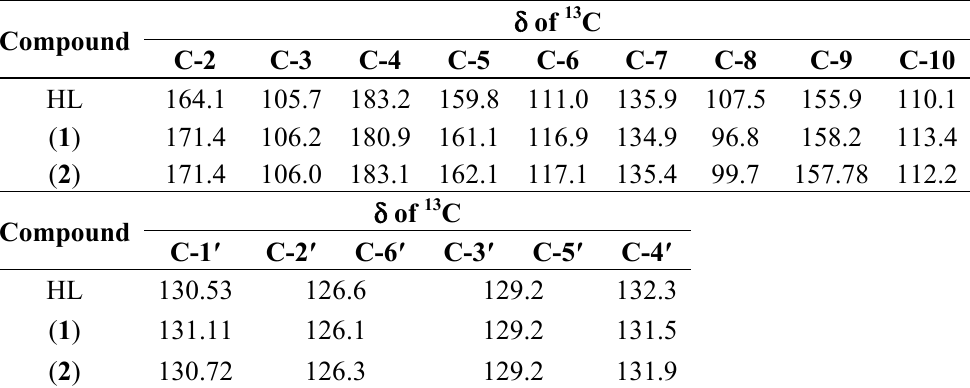
Table 6. The 13 C chemical shifts (ppm) for ligand and complexes.